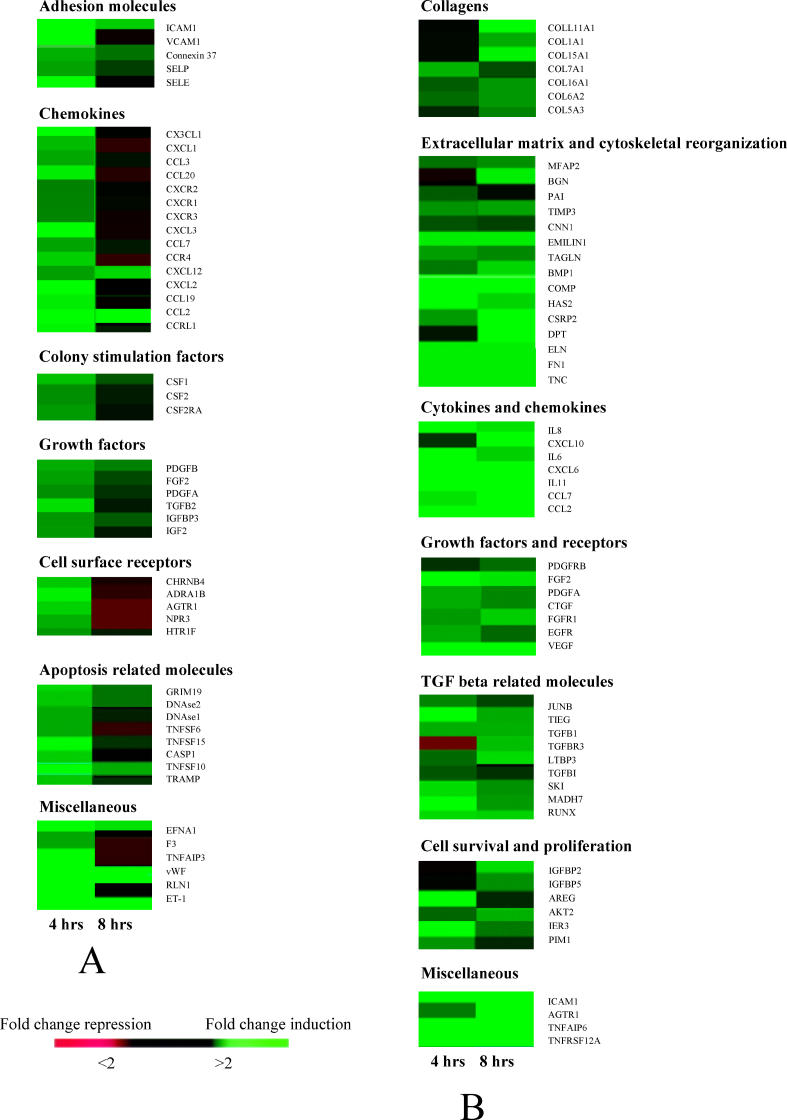
Profile of Selected Genes Modulated in Response to Anti-hCMV AntibodiesFigure shows F.C. in gene expression in endothelial cells (A) and fibroblasts (B) at 4 and 8 h after incubation with affinity purified anti-UL94 antibodies. Genes are grouped into functional categories based on our current understanding of their function. Genes shown have at least a 2-fold change in gene expression.